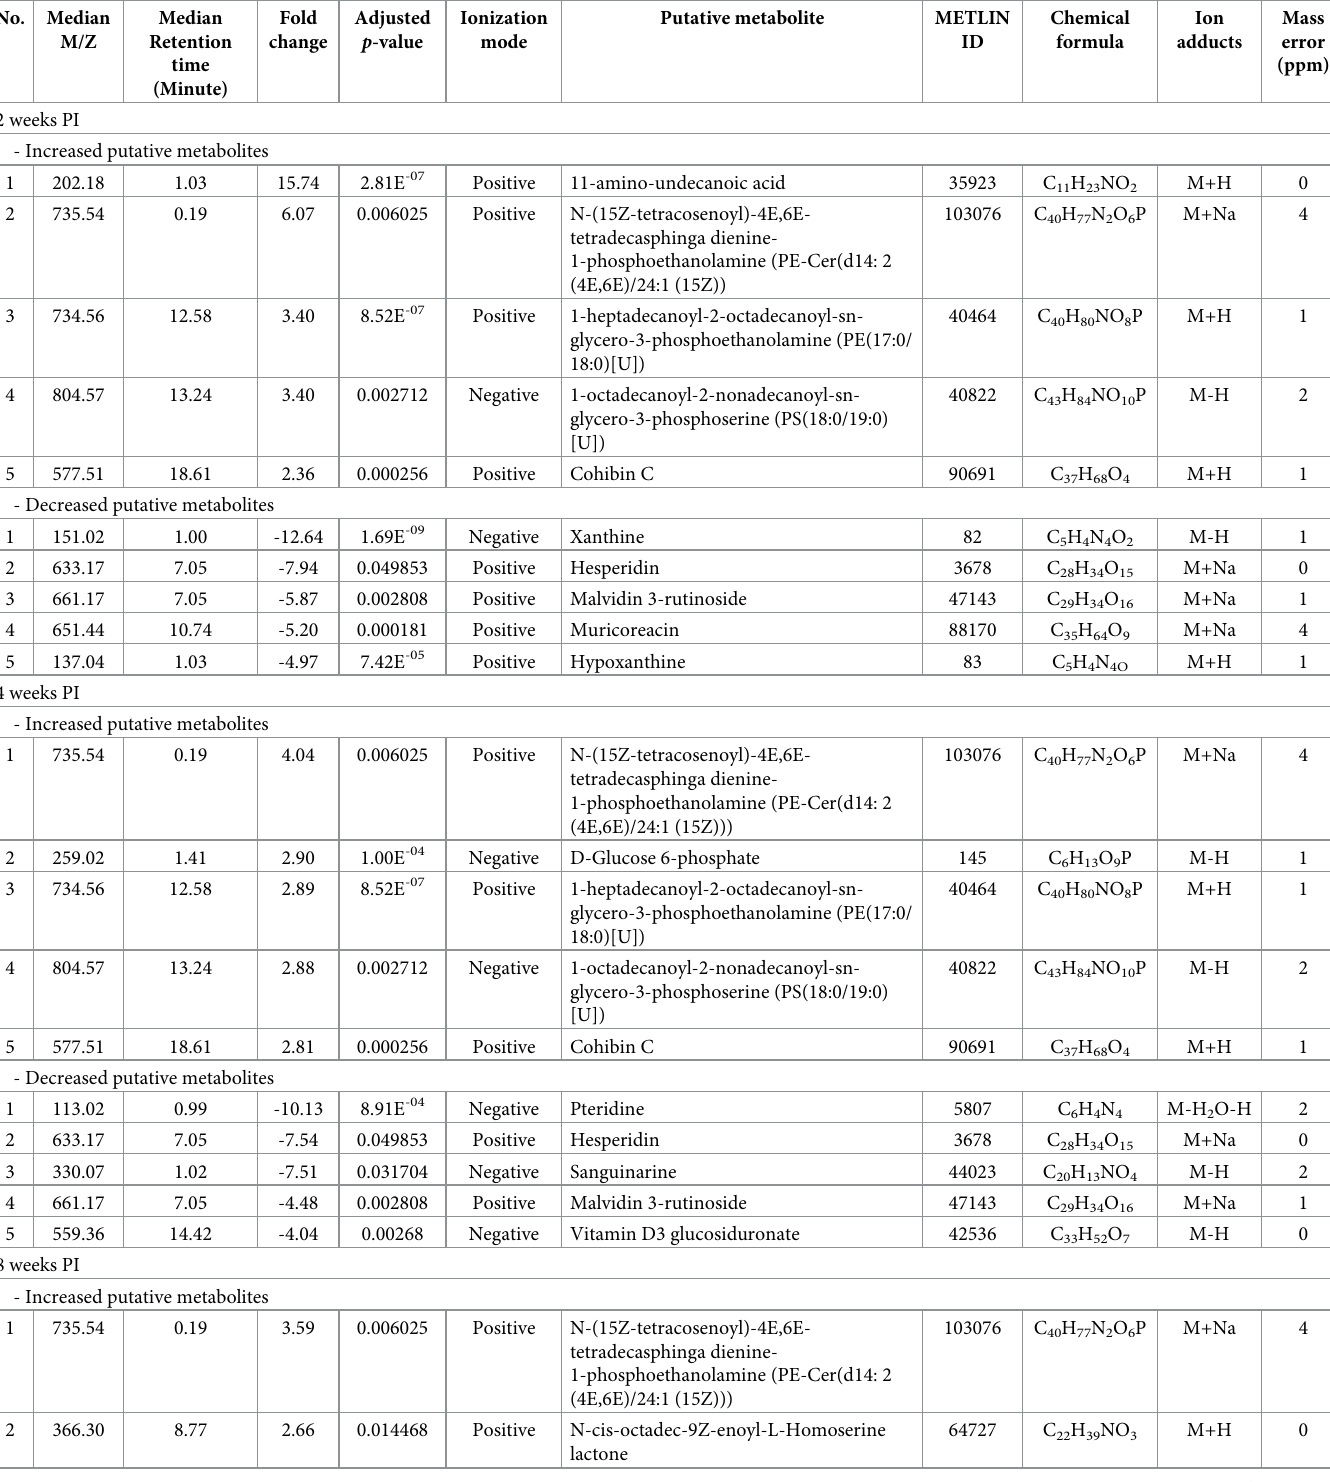
Table 1. Top-5 putative metabolites from each time-point after T . spiralis infection (ranked by fold change). No. Median